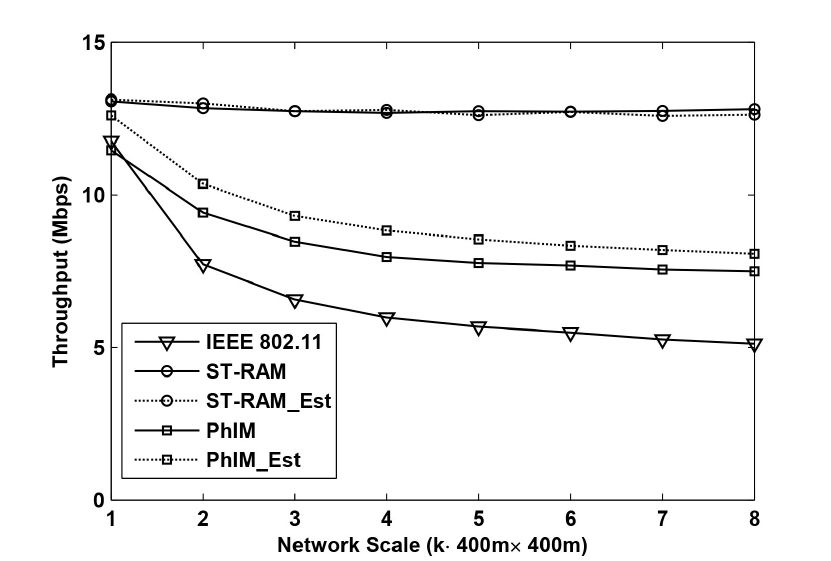
Figure 5. Throughput performance of different data collection methods for lattice deployed networks with different